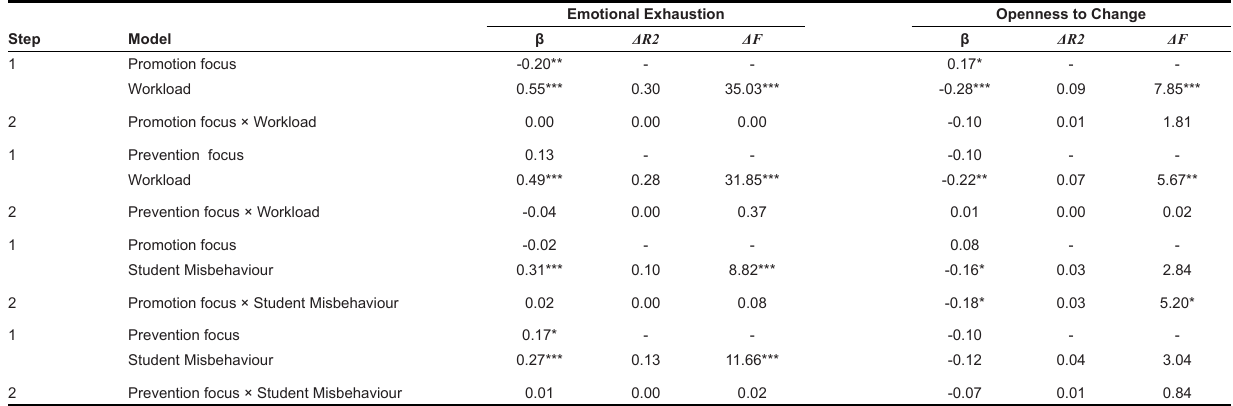
TABLE 3 Regression of emotional exhaustion and openness to change on job demands, promotion and prevention focus in sample 1 ( N = 164) Emotional Exhaustion Openness to